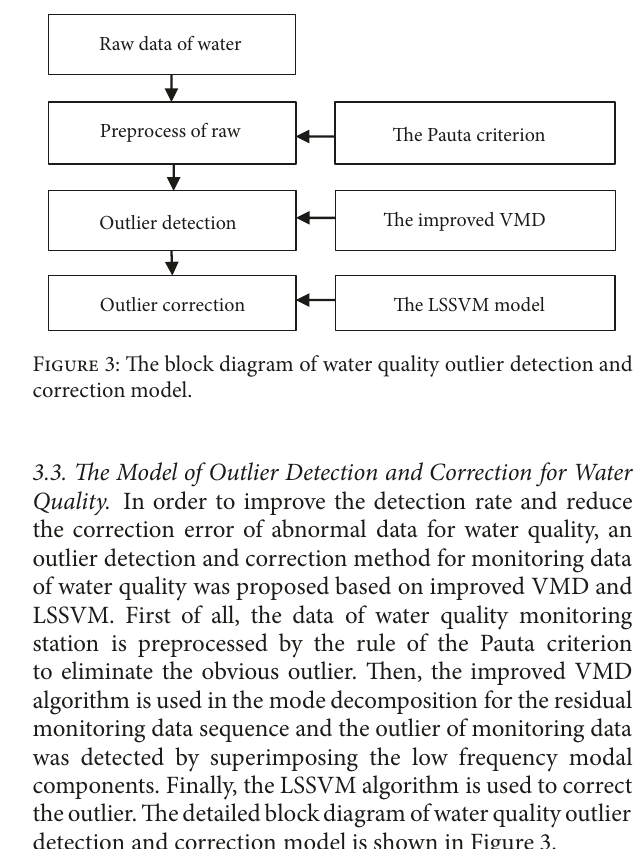
Figure 2: The flow chart of LSSVM algorithm optimizations.